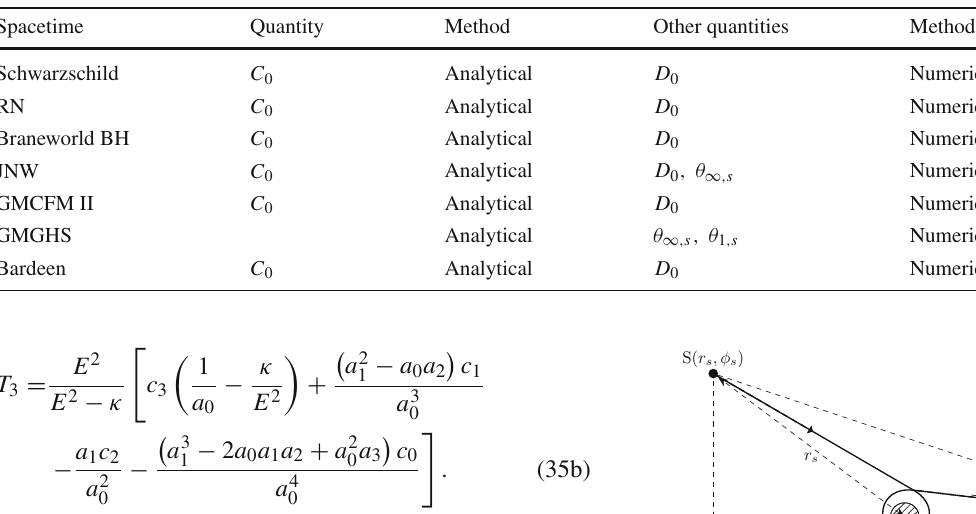
Table 1 Comparison of our work and known literatures. The columns are respectively the spacetime name, the quantities compared, the method used for comparison and the corresponding reference. Note that the coefficient D 0 in Ref. [16] (denoted as ¯ b ) seems at odds with all other works. JNW, GMCFM and GMGHS stands for